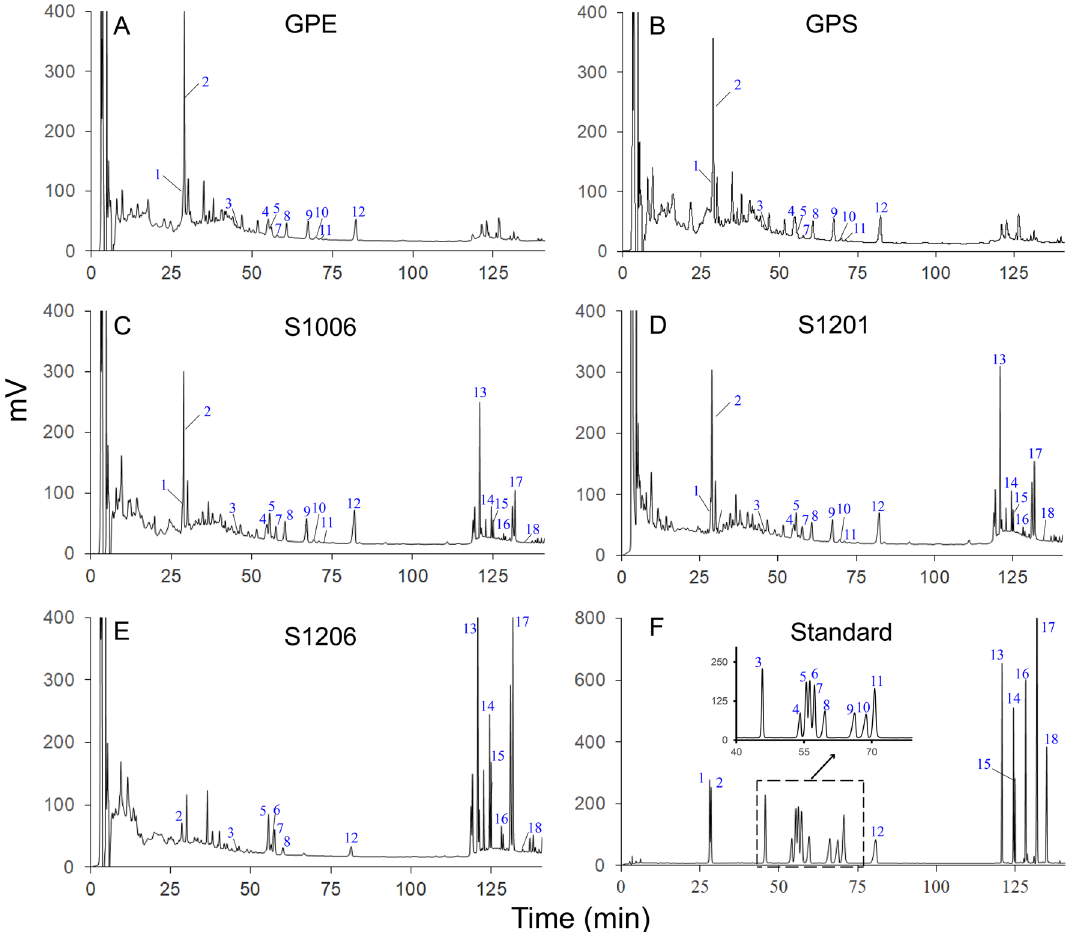
Figure 1. HPLC analyses of ginsenosides in extracts from raw and steamed ginseng pulps or ginseng pulp soaking supernatant. Shown here are chromatograms of ( A ) raw ginseng pulp extract (GPE); ( B ) ginseng pulp soaking supernatant extract (GPS); ( C ) GPS steamed for 6 h at 100 °C (S1006) and ( D ) for 1 h at 120 °C (S1201) and ( E ) GPS steamed for 6 h at 120 °C (S1206); and ( F ) standards of the 18 ginsenosides. ( F ) Ginsenosides marked are: (1) Rg 1 , (2) Re, (3) Rf, (4) Rb 1 , (5) 20( S )-Rg 2 , (6) 20( S )-Rh 1 , (7) 20( R )-Rg 2 , (8) Rc, (9) Rb 2 , (10) Rb 3 , (11) F within ( F ) is an amplification of the partial profile between 40 and 85 min as indicated by the dashed